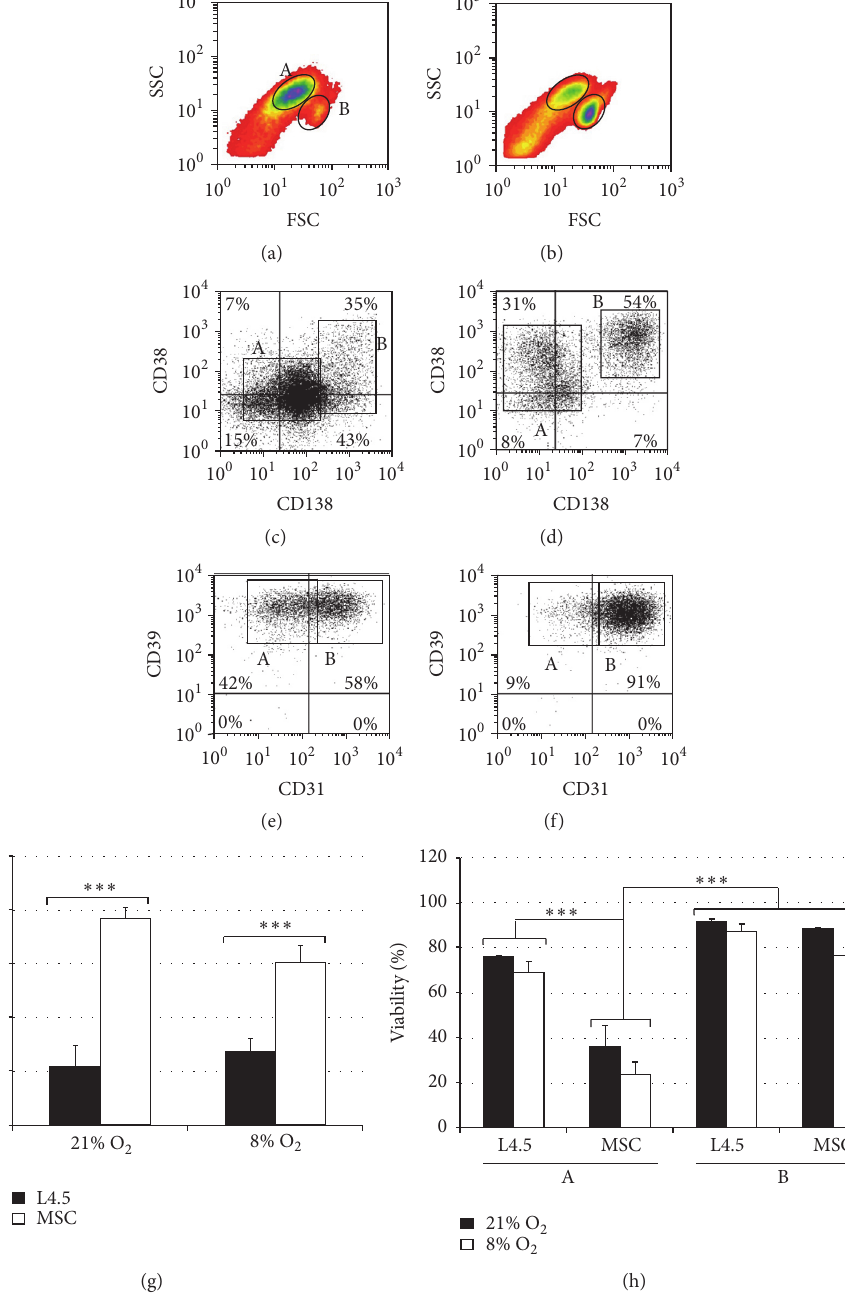
Figure 5: Two subsets of differentiated B lymphocytes can be distinguished according to their size and granularity. Switched memory B lymphocytes were cultured as described in Figure 2(a) during the expansion and transition phases. For the differentiation phase, cells were grown in the presence of L4.5 cells or MSC. All assays were done in parallel at 21% and 8% O 2 and analyses were done on day 20. (a) and (b) Profiles of populations A and B as revealed by size (FSC) and granularity (SSC) parameters. (c) and (d) Expression of CD38 and CD138 and (e) and (f) expression of CD31 and CD39 were determined and corroborated with populations A and B. Profiles shown in (c)–(f) are representative of five independent samples. (g) Relative frequencies (RF) of CD38 high CD138 + were determined for B populations using this formula: RF = B ÷ ( A + B ) . (h) Viability in A and B populations is shown for all conditions tested. Results in (g) and (h) are presented as the mean ± SEM of five independents experiments. Statistical analyses were done using Dunn multiple comparison 𝑡 -test with ∗∗∗ 𝑝 ≤ 0.001